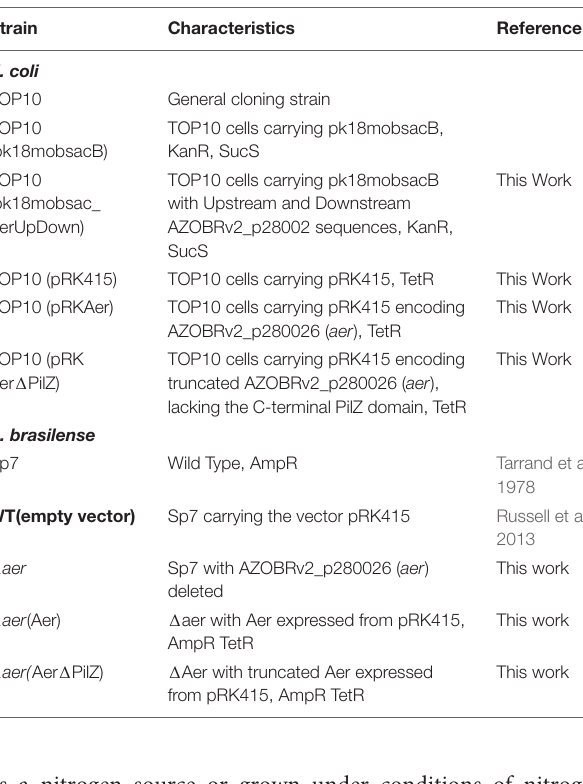
TABLE 1 | List of strains used in this study.